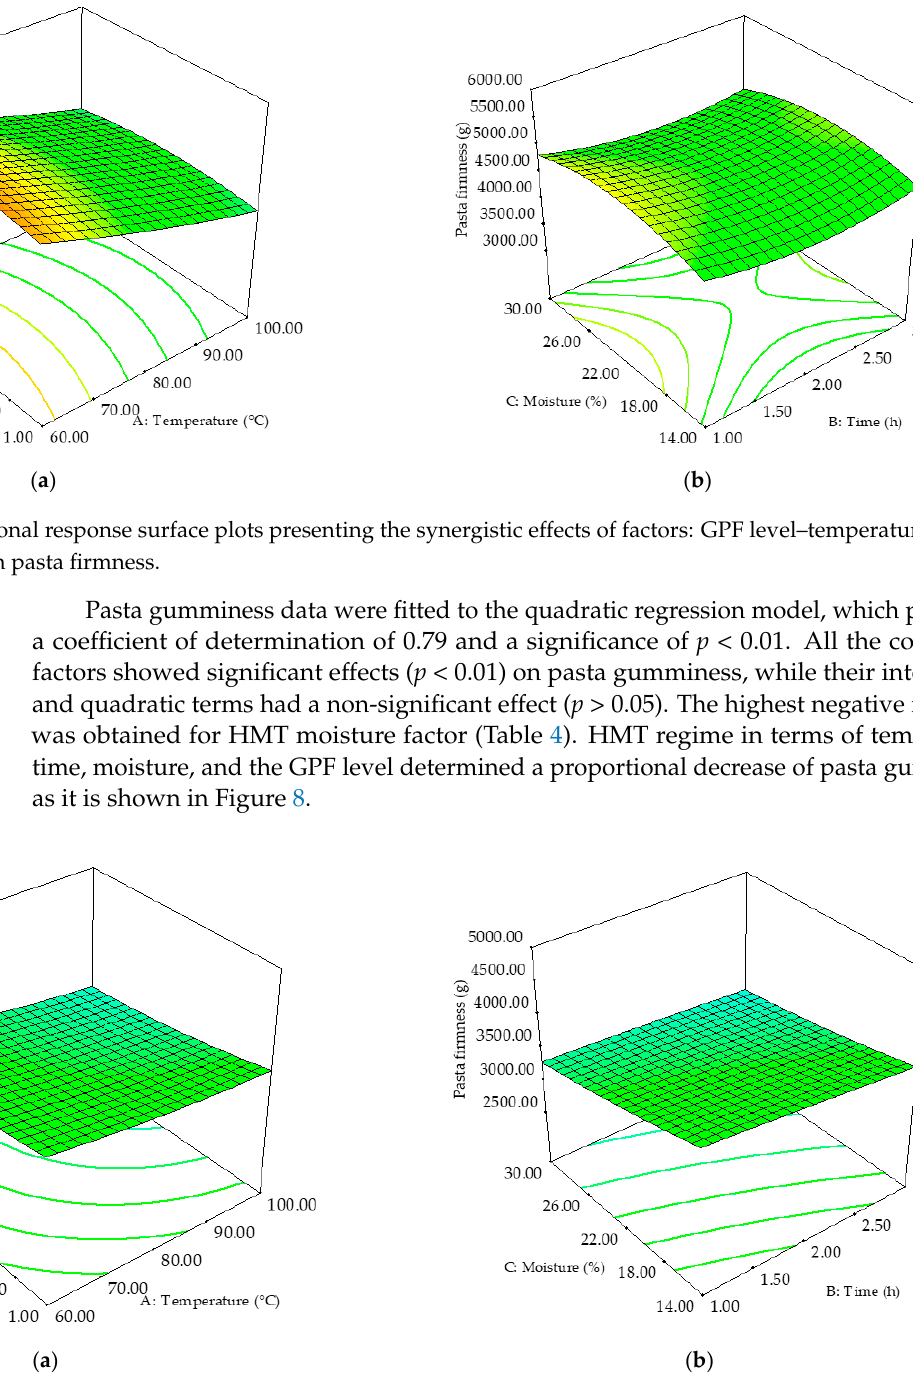
( b ) Figure 9. Three-dimensional response surface plots presenting the synergistic effects of factors: GPF level–temperature ( a ) and moisture-time ( b ) on pasta resistant starch (RS). HMT temperature increase up to 80 °C determined RS increase. A similar trend was observed for time factor and moisture up to 22%. GPF addition level increase resulted in a proportional RS contents rise (Figure 9).